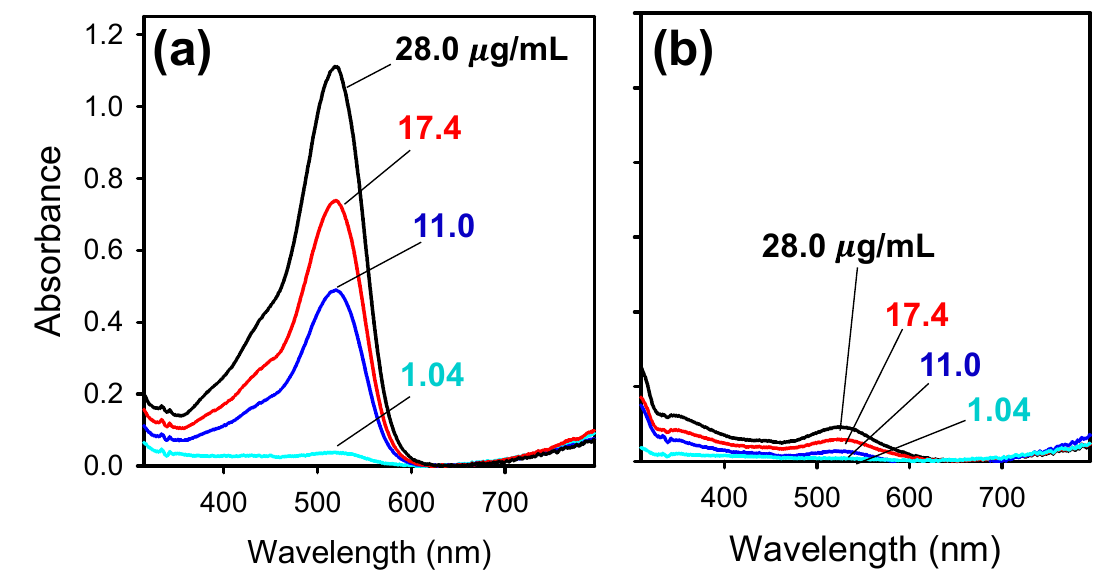
Figure 2. Representative UV–VIS absorption spectra of anthocyanin (Cy3G) standards of different concentrations (as listed) at ( a ) pH 1.0 and ( b ) pH 4.5.